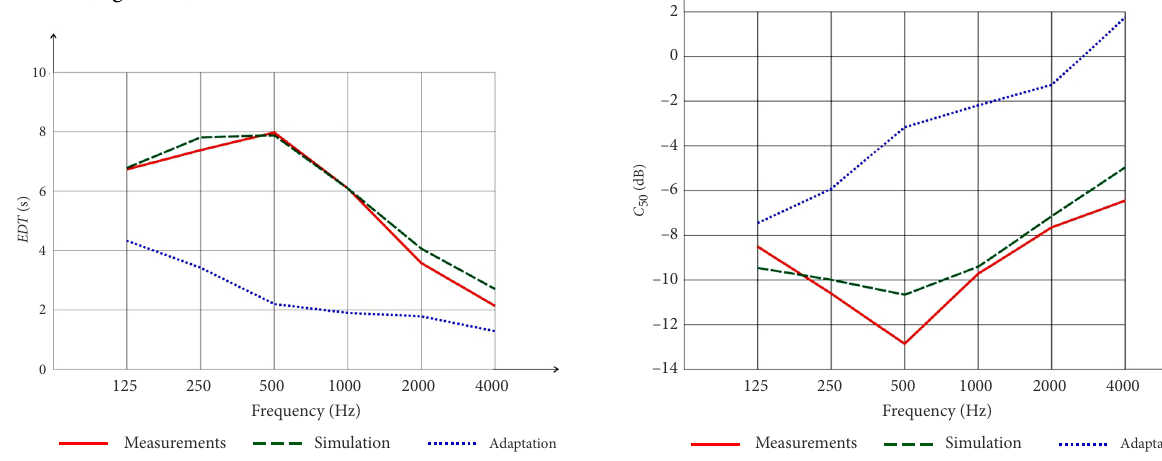
Figure 15. Graph of Clarity C 50 in the frequency function – comparison of in situ measurements, simulation and simulation with acoustic adaptation